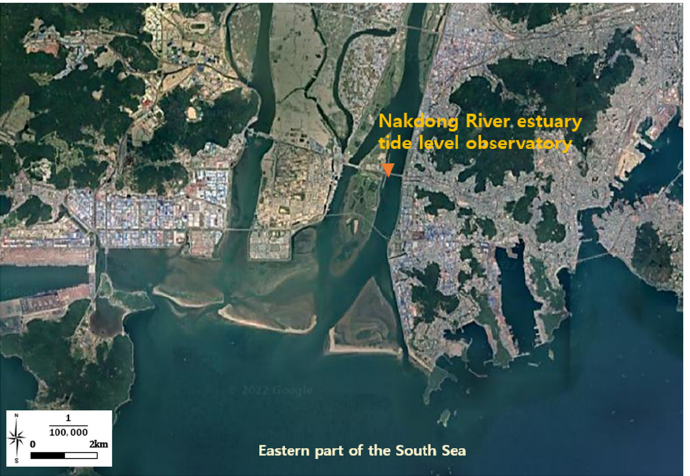
Figure 1. Location of the tide observation station at the estuary of Nakdong River in Busan, Republic of Korea.